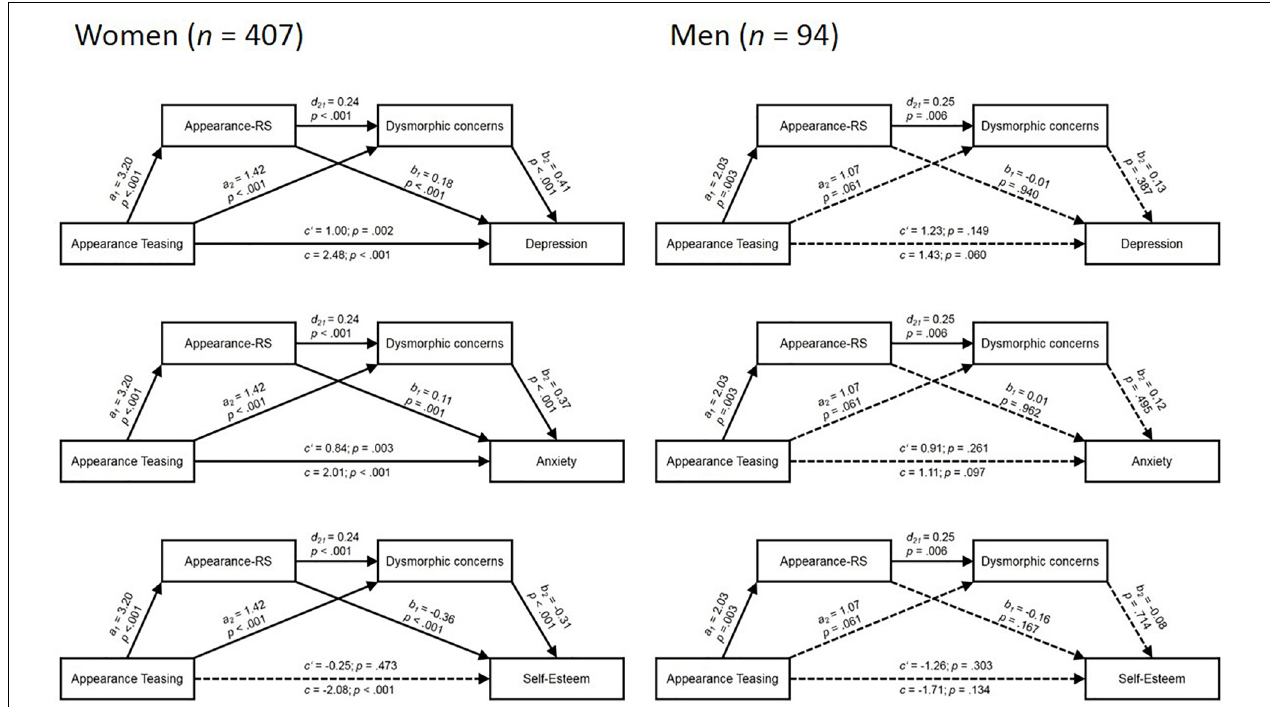
FIGURE 2 | Gender-specific serial mediation models. Appearance-RS, appearace-based rejection sensitivity.